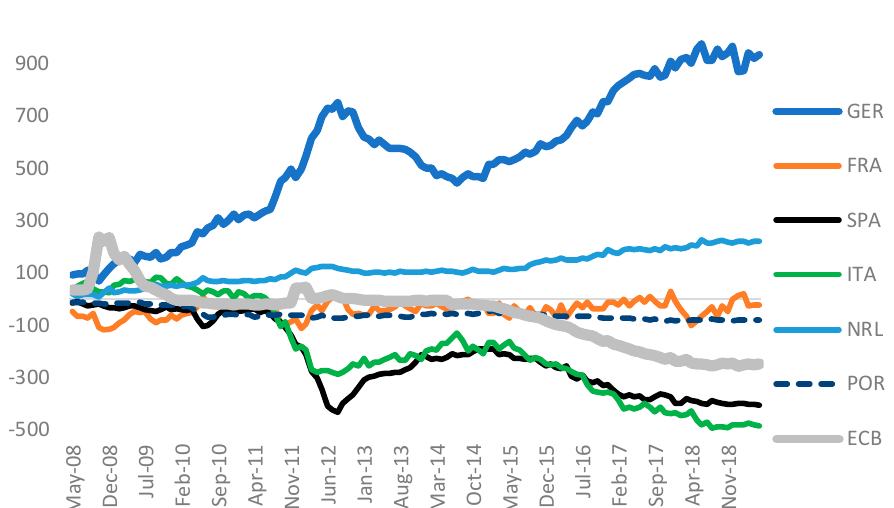
Figure 5. Target 2 Balances in the European System of Central Banks. Source: Thomson Reuters.